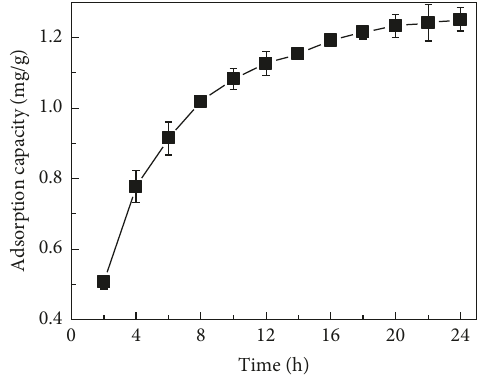
Figure 6: Adsorption kinetics